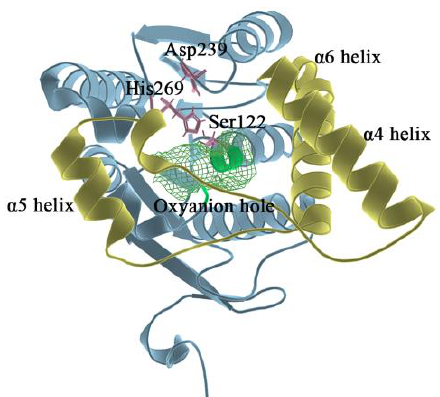
Figure 1. In the overall 3D structure of monoacylglycerol lipase, yellow represents the lid domain, pink represents the catalytic triads, green mesh pattern represents the oxyanion hole, and other regions are shown in blue.